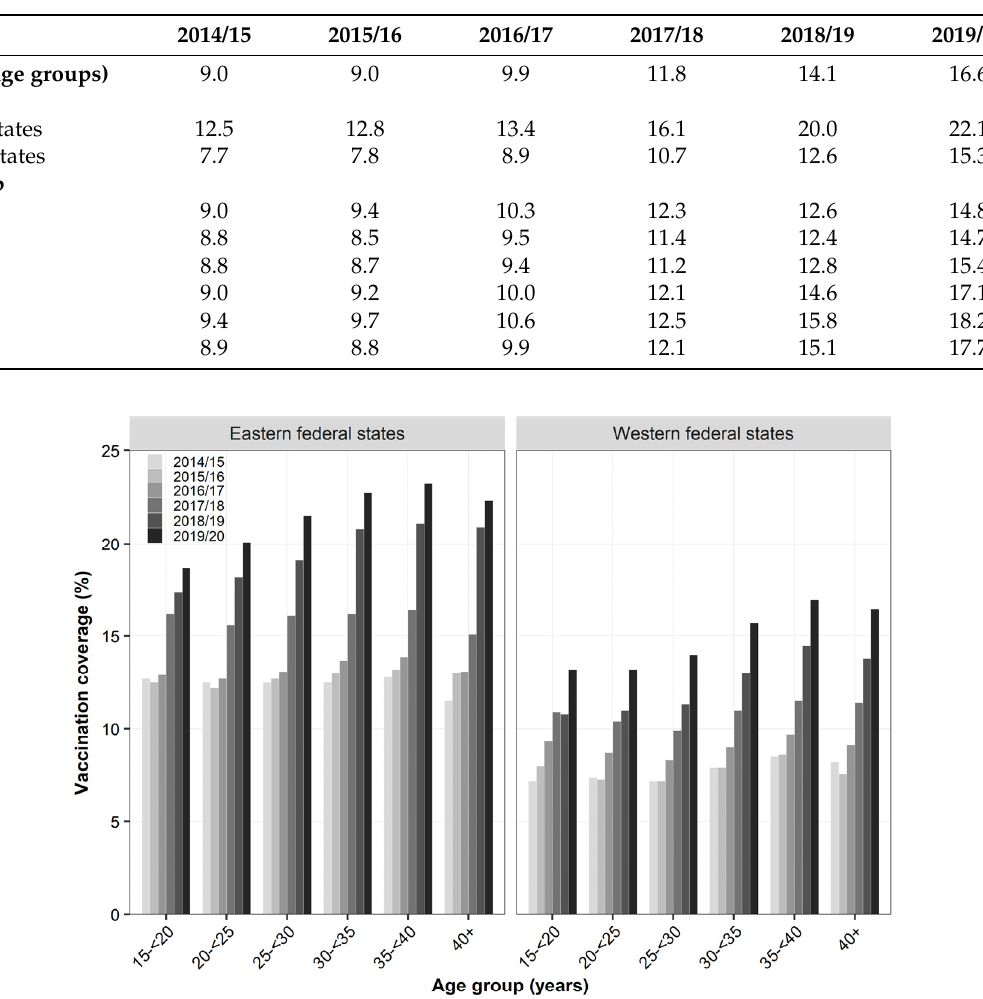
Table 2. Influenza vaccination coverage (%) during pregnancy based on outpatient claims data, by region and age group, seasons 2014/15 to 2019/20.